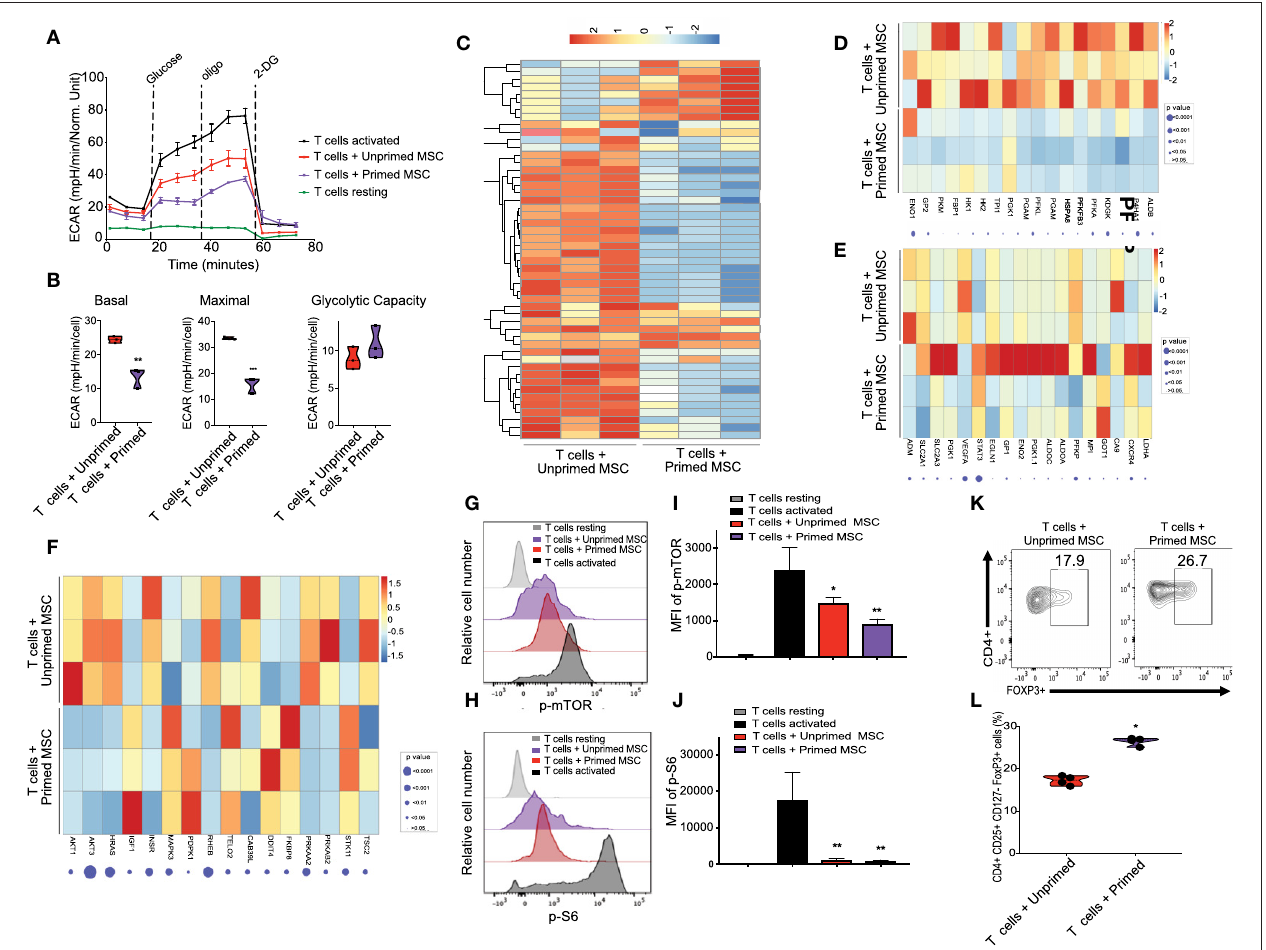
FIGURE 3 | Enhanced immunosuppressive effect of primed CB derived MSC on co-cultured T cells in-vitro . (A) Representative graph of extracellular acidification rate (ECAR) showing the reduction of glycolysis switch of T cells during their activation by their coculture with unprimed MSCs (red line) and primed MSCs (purple), compared with resting T cells (black line, round symbol) and CD3/CD28 activated T cells (black line, square symbol) ( n = 3). (B) Violin plots summarizing the ECAR data, basal ECAR (left panel), maximal ECAR (central panel), and glycolytic capacity (right panel) of activated T cells cocultured for 24h with unprimed MSCs (red) and primed MSCs (purple). Statistical significance is indicated as ** p ≤ 0.01; bars represent mean values with standard error of mean. (C) Heatmap showing differential gene expression data of T cells cocultured with primed MSCs vs. unprimed MSCs after 48h, q < 0.05 and absolute log 2 fold change > 2, n = 3. (D) Heatmap showing genes of glycolysis pathway (from GSEA analysis) that are downregulated in T cells cocultured with primed MSCs compared with unprimed MSC. (E) Heatmap showing genes of hypoxia pathway that are enriched in T cells cocultured with primed MSCs compared with unprimed MSCs in primed MSC. (F) Heatmap of mTOR associated genes that are downregulated in T cells cocultured with primed MSCs vs. unprimed MSC. G-H) Representative experiment indicating mTOR S2448 phosphorylation (G) and S6 S235/S236 phosphorylation level (H) of T cells resting (gray), CD3/CD28 activated T cells (black), activated T cells cocultured with unprimed MSCs (red), and activated T cells cocultured with primed MSCs (purple) for an additional 48h ( n = 3). (I,J) Bar graphs showing the Median Fluorescence Intensity (MFI) of pmTOR S2448 phosphorylation (I) and S6 S235/S236 phosphorylation (J) derived from three independent experiments. Statistical significance is indicated as * p ≤ 0.05; bars represent mean values with standard error of mean. (K) Representative contour plots showing the induction of Treg (CD4 + CD24 + CD127- FOXP3 + ) after 5 days of coculturing with unprimed MSCs (left plot) vs. primed MSCs (right plot). Numbers indicate frequency of the gated population. (L) Percentage of Treg generated by the coculture of T cells with unprimed (red) vs. primed (purple) MSC derived from three independent experiments. Statistical significance is indicated as * p ≤ 0.05; bars represent mean values with standard error of